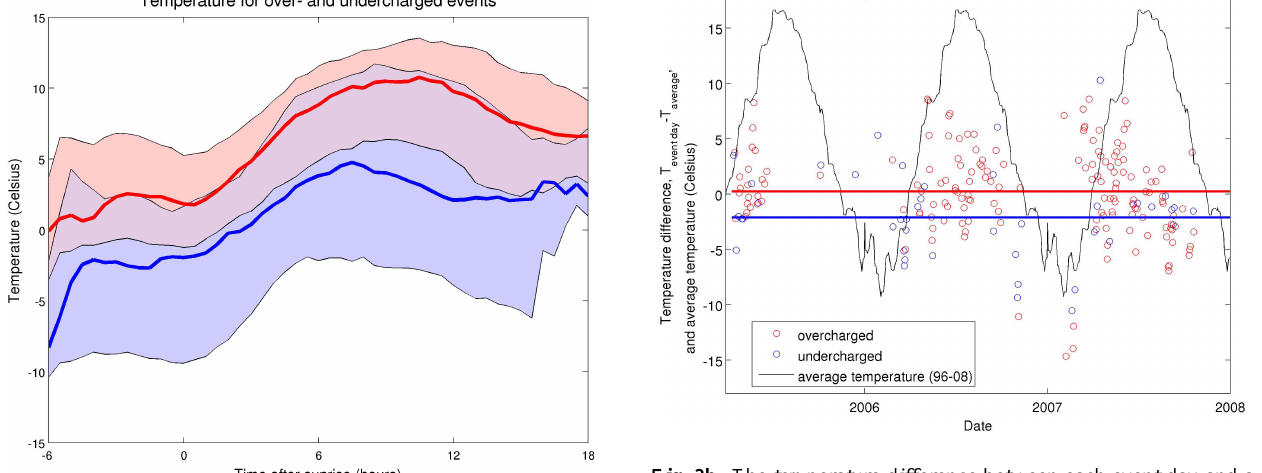
Fig. 3b. The temperature difference between each event day and a 1996–2008 average for the same day is presented for overcharged (in red) and undercharged (in blue) events. The medians for over- and undercharged days were 0.23 ◦ C and − 2.13 ◦ C (horizontal red and blue lines, resp.) and the means were 0.32 ◦ C and − 1.87 ◦ C, respectively. The black line shows the 12 year average temperature smoothened over 10